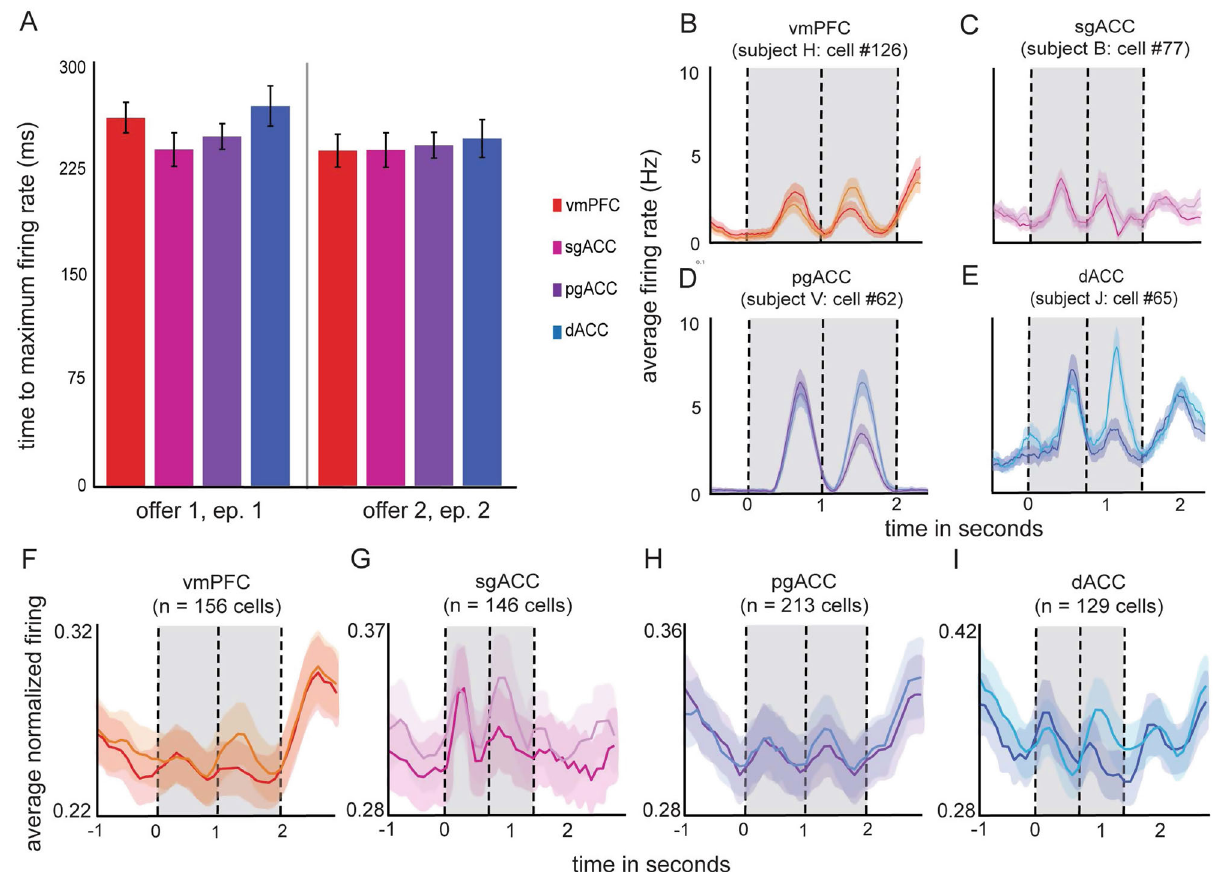
Fig. 2 Response latency and traces of average fi ring rates across all trials drawn from responses of single sample neurons. A Bars plot the average latency to maximal fi ring rates in response to the onset of both offer 1 and offer 2 (red = vmPFC: n = 156 neurons; pink = sgACC: n = 146 neurons; purple = pgACC: n = 213 neurons; blue = dACC: n = 129 neurons). Error bars indicate the standard error across trials. Source data are provided as a Source Data